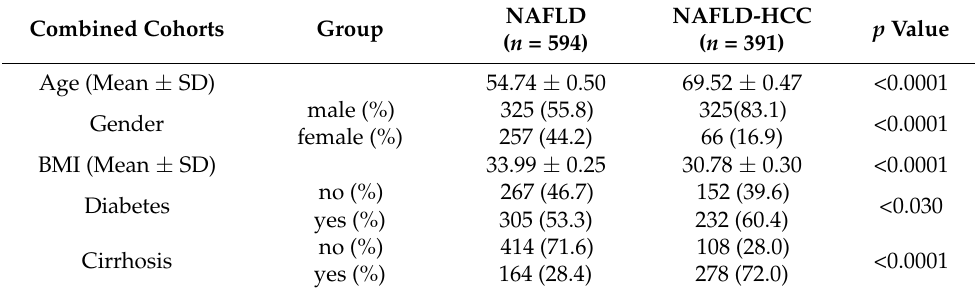
Table 5. The demographic characteristics of the combined European cohort.